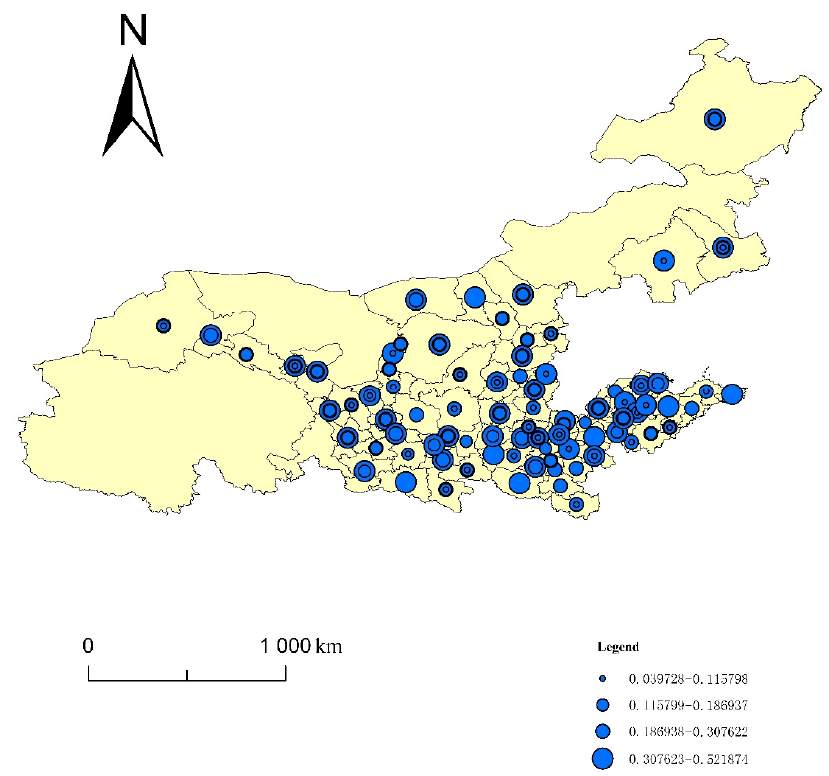
Figure 3. Spatiotemporal evolution of the urban ecological support capacity in the YRB.